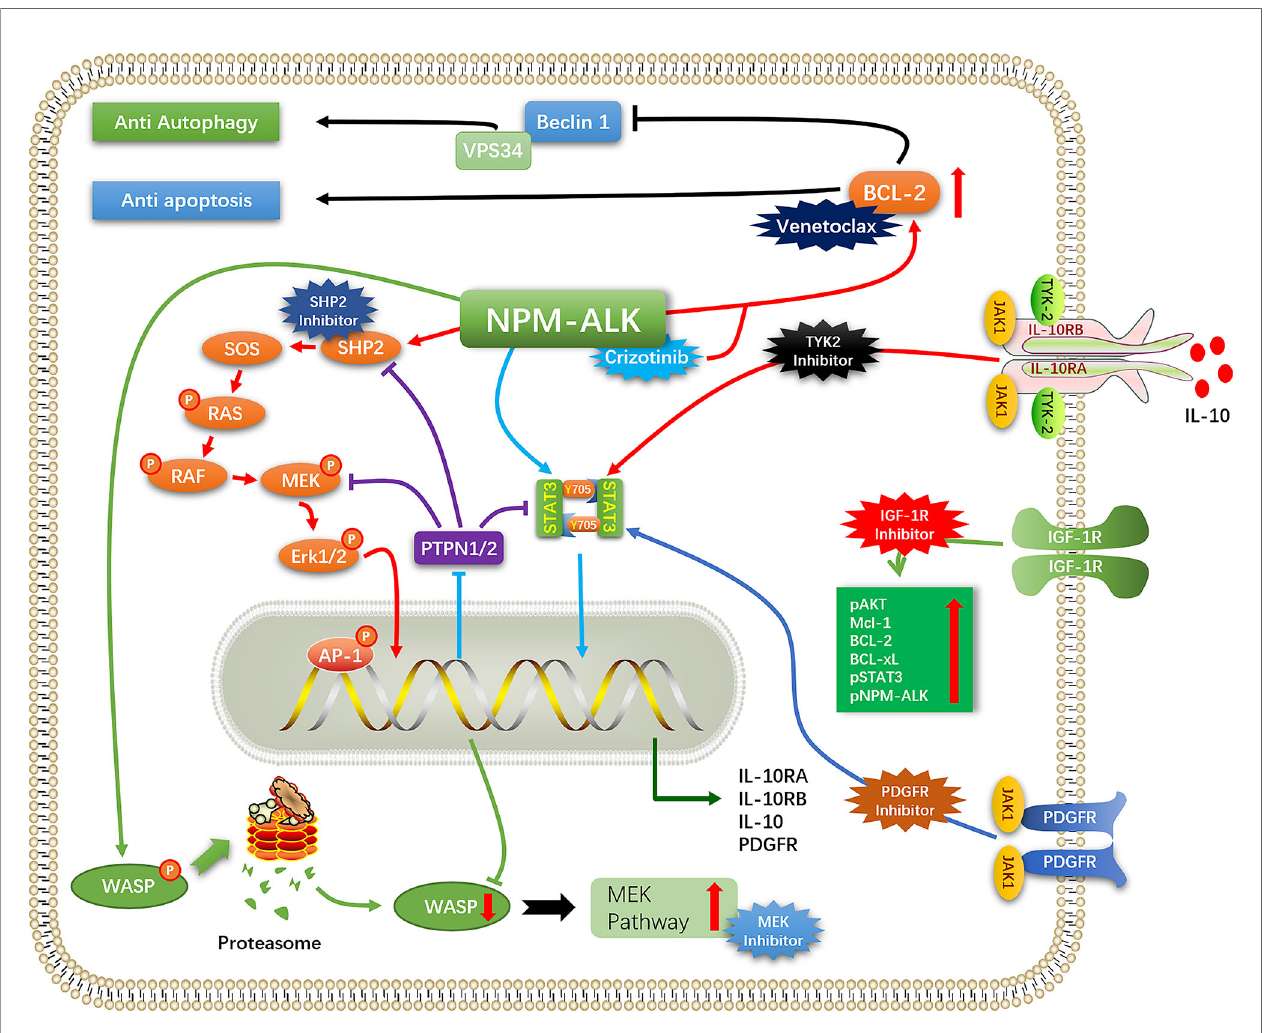
FIGURE 2 | Mechanisms of resistance to